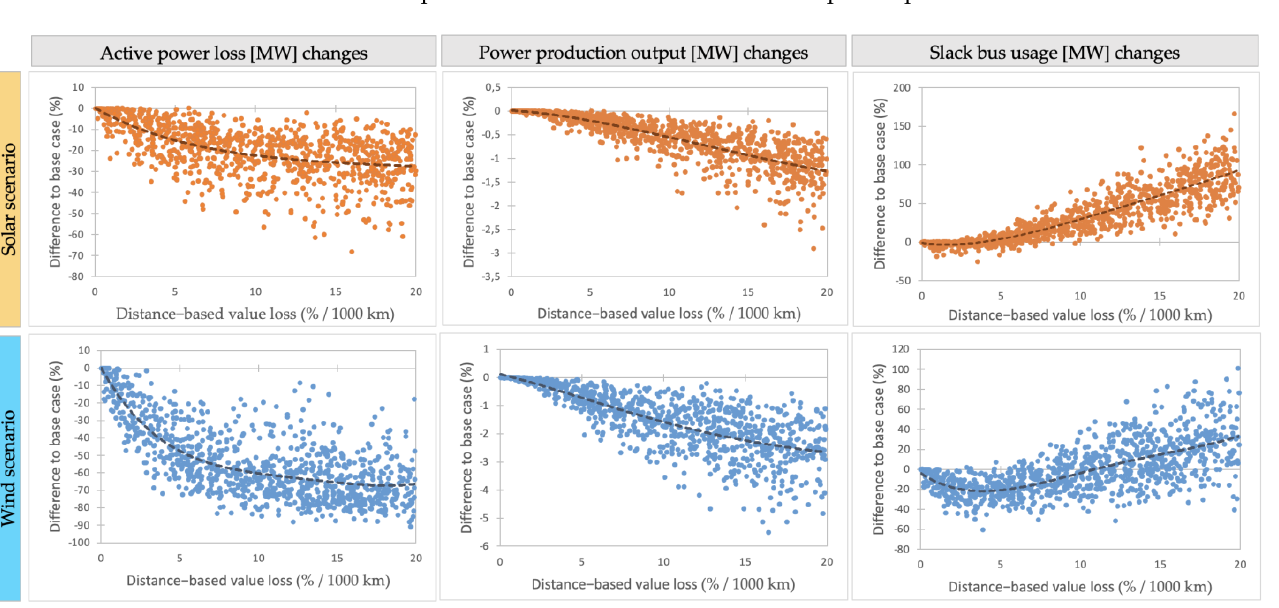
Figure 4. Results of the overall power flow changes for the wind and solar scenarios.